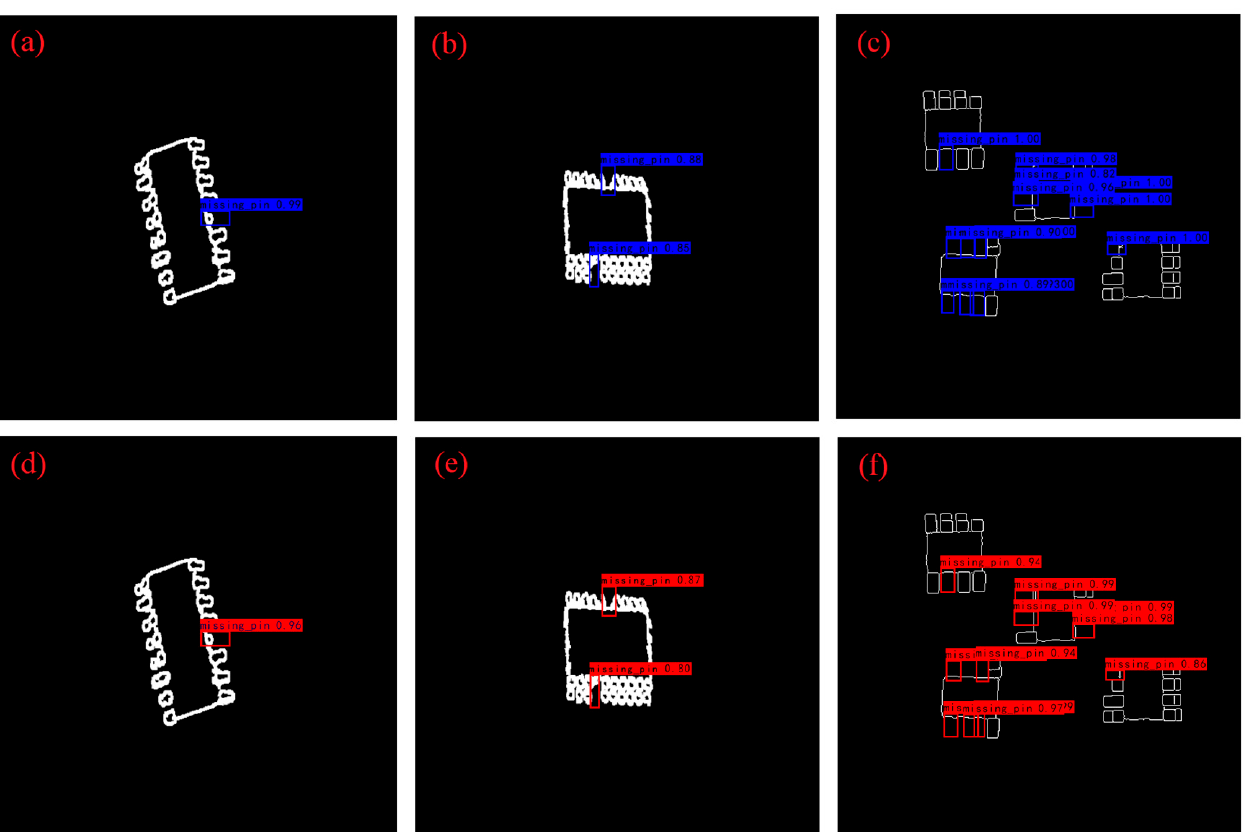
Figure 8. Inference results. ( a ) The result of the CPU inferring SOP16 chip. ( b ) The result of the CPU inferring SOP20 chip. ( c ) The result of the CPU inferring multiple SOP8 chips. ( d ) The result of the FPGA inferring SOP16 chip. ( e ) The result of the FPGA inferring SOP20 chip. ( f ) The result of the FPGA inferring multiple SOP8 chips.